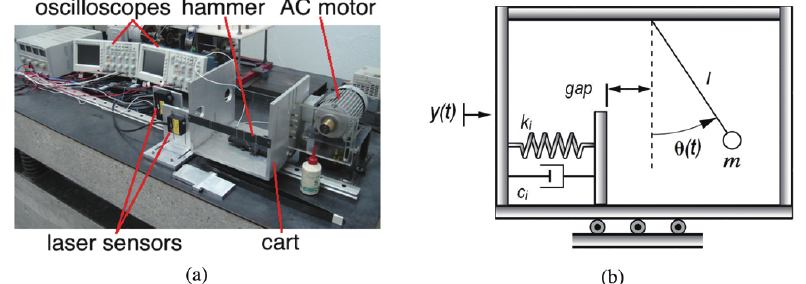
Fig. 2. Test rig: a) Picture of the entire test rig, including acquisition hardware; b) Physical representation.